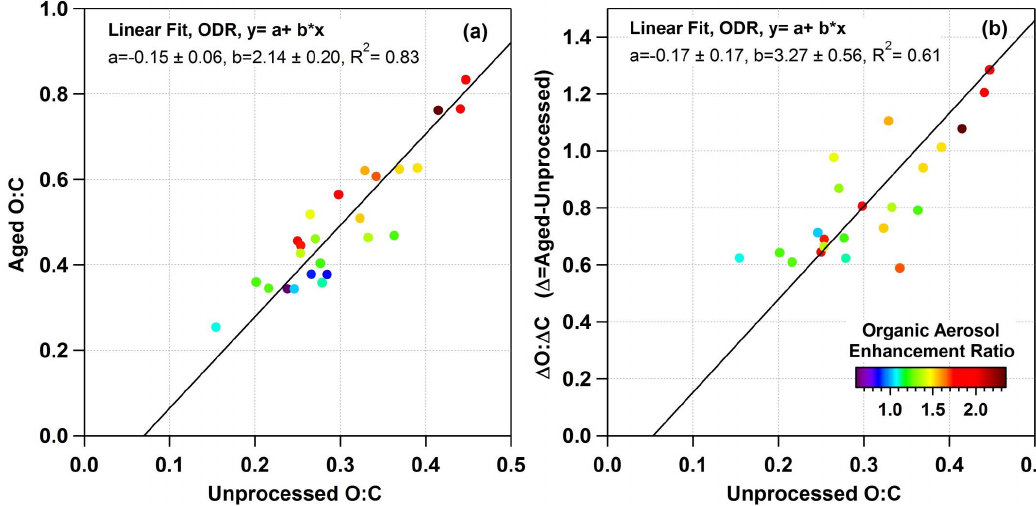
Fig. 14. Changes in O/C from aging fresh smoke. (a) Maximum O/C from aging as a function of unprocessed smoke O/C. (b) The ratio of change in oxygen (aged/unprocessed) to the change in carbon (aged/unprocessed) as a function of unprocessed O/C for fuels where this ratio is positive (ER OA >1). Both plots are colored by organic aerosol enhancement ratio (ER OA )